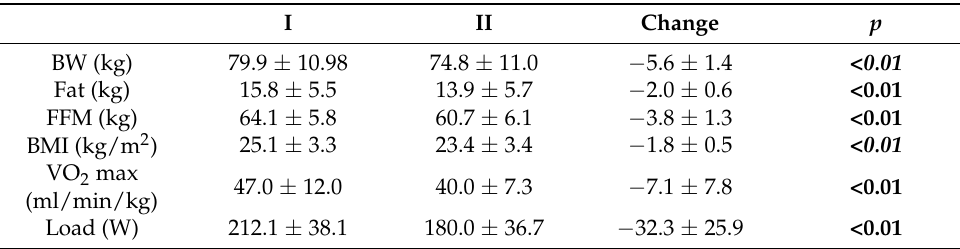
Table 1. Anthropometric and physiological characteristics of the study